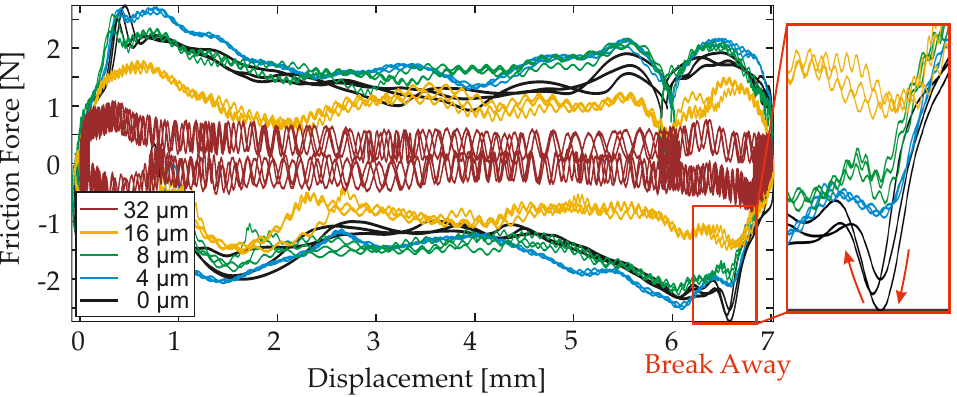
Figure 8. Force − displacement curves for NBR70 at v rel of 50